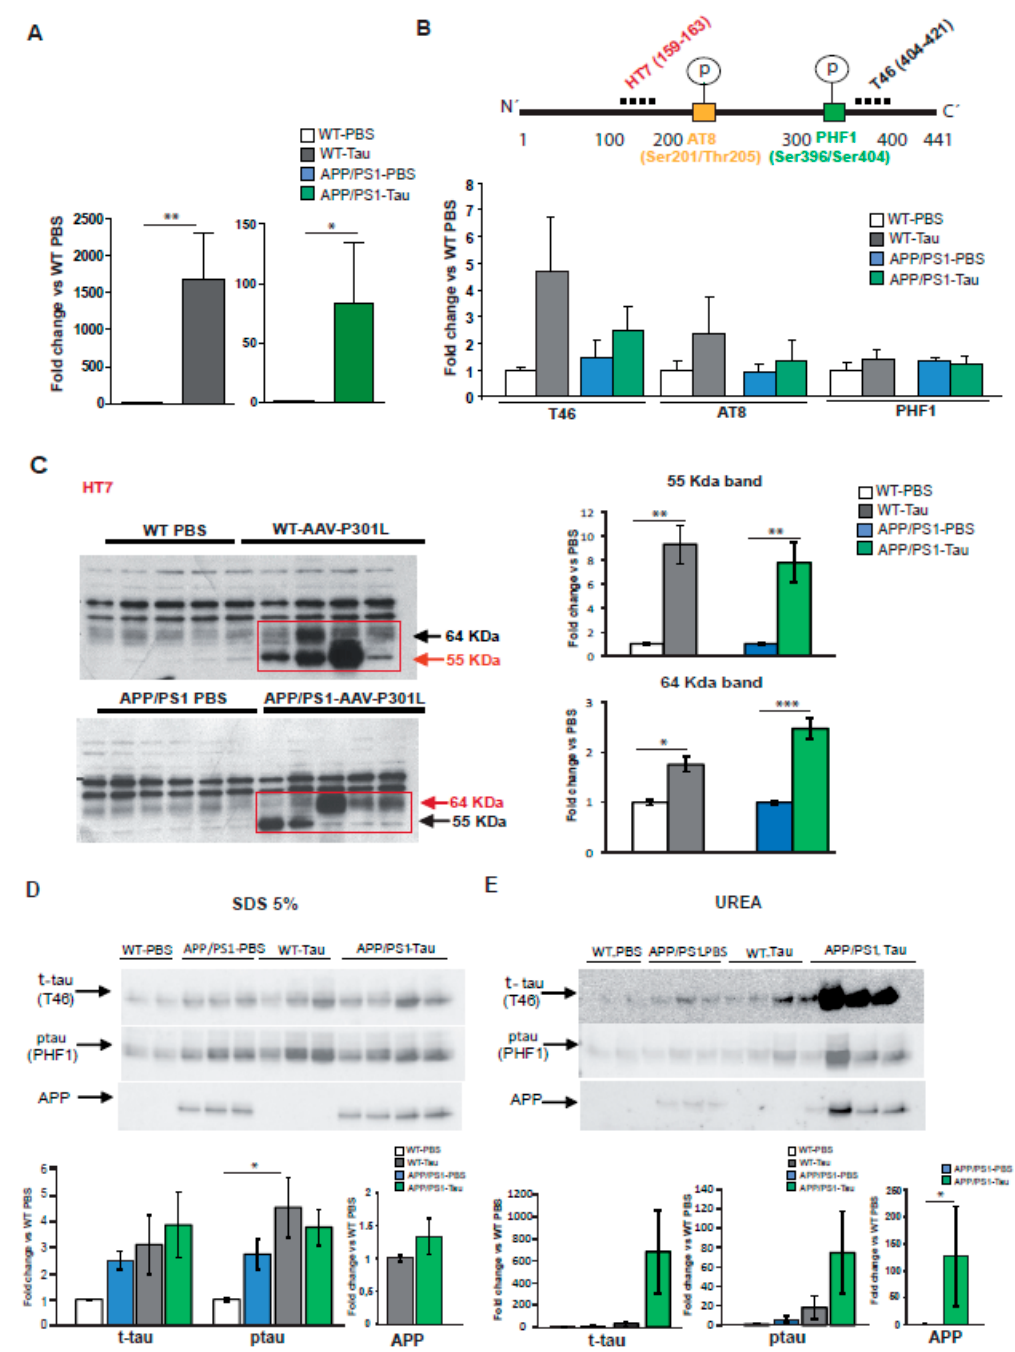
Figure 4. Hippocampal AAV-9-hTauP301L over-expression in APP/PS1 mice accelerates Tau pathology. ( A ) mRNA levels of human tau were detected by qRT-PCR in wild type (WT) and APP/PS1 mice injected with PBS or with AAV-9-hTauP301L ( n = 3). ( B ) Schematic representation shows tau protein and the location of epitopes for the antibodies used in this study. Western blots showing the effects of PBS- or AAV9-hTauP301L injection in WT and APP/PS1 mice in tau and ptau expression using different antibodies to detect total tau (T46) and ptau (AT8, PHF1), normalized to actin, in 2% SDS hippocampal extracts ( n = 5–6). ( C ) Same extracts were used to analyze the levels of human tau using HT7 antibody and bis/tris gels normalized to actin. Quantifications of the corresponding 55 and 64 Kda bands in the western blot are shown. Data are presented as mean ± SD; ( n = 5–6). Statistics were performed by a Student’s t text. * p < 0.05, ** p < 0.01, *** p < 0.001 vs. PBS. (D-E) Western blots of 5% SDS-soluble fraction (S2, ( D )) and insoluble fraction (urea, S3, ( E )) probed for anti-total tau (T46), anti-ptau (PHF1) and anti-6E10 (recognize the amyloid precursor protein, APP) antibodies ( n = 5–6). Statistics were performed by two-way ANOVA, * p < 0.05.